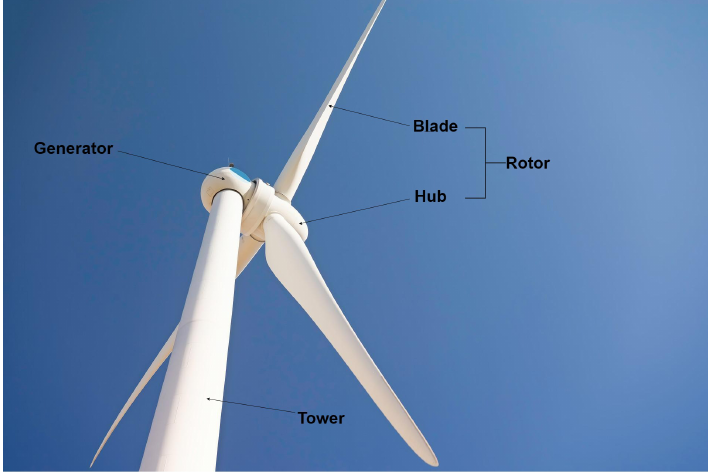
Figure 3. Main components of a wind